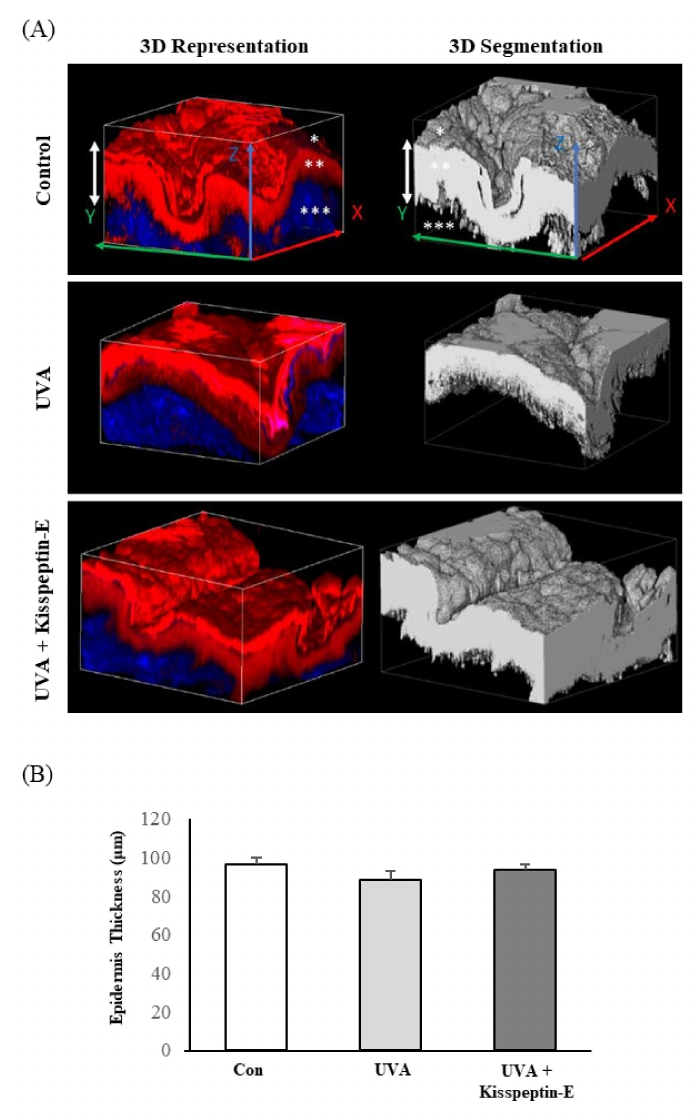
Figure 6. Kisspeptin-E recovered the epidermal thickness in UVA irradiated human skin explants. Human skin explants were topically treated with Kisspeptin-E and with UVA irradiation. ( A ) After treatment, human skin explants were fixed with formalin, and the cytoplasm of keratinocytes was labeled using a fluorescent cell tracker. Then, 10 z-stacks were acquired on each sample by confocal microscopy (epidermis in red, dermis in blue, white arrow is epidermis thickness, * stratum corneum, ** epidermis, *** dermis) (Zeiss LSM510 NLO). We delimited and quantified the volume to extract the average thickness of the epidermis with Amira ® software (Thermo Fisher Scientific, Waltham, MA, USA). ( B ) The average thickness of 10 z-stacks ± SE at mean per conditions was